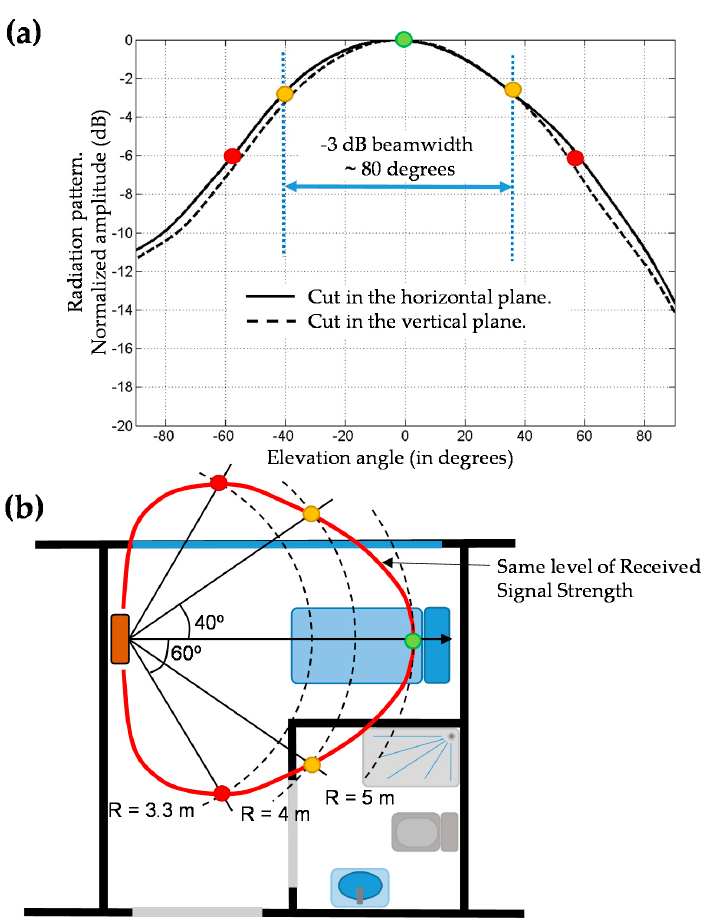
Figure 2. ( a ) Radiation pattern of a directive UHF RFID. Main cuts are depicted, highlighting the − 3 dB beamwidth. ( b ) Representation of the coverage area of the RFID antenna: red line represents all the points that receive the same signal strength taking into account indoor propagation model losses and the radiation